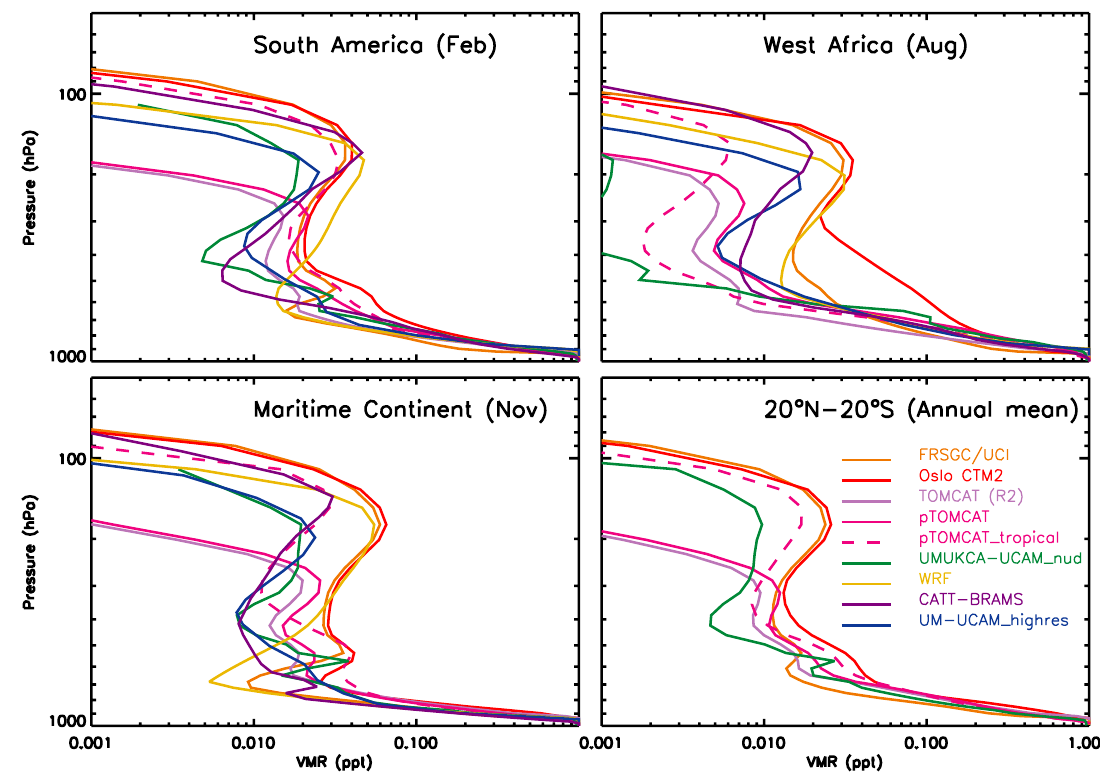
Fig. 2. The mean profile of T6h volume mixing ratios, for each model, averaged over three different areas for particular months of 2005, as well as an annual mean for the tropical region (lower right